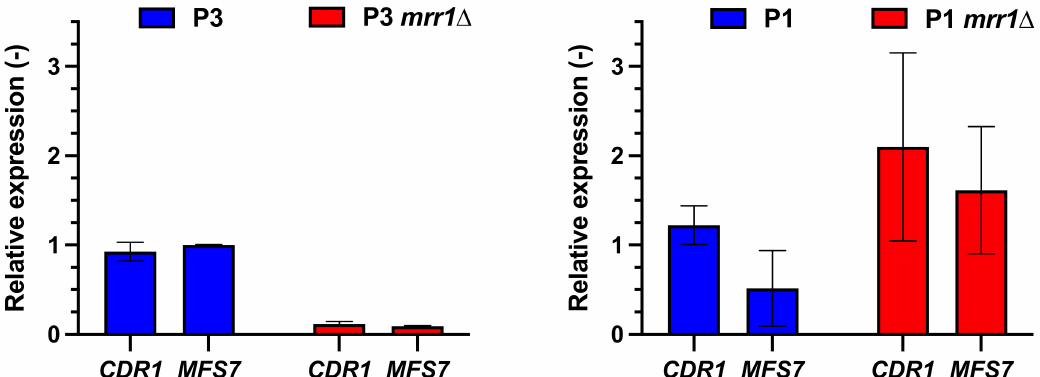
Figure 2. CDR1 and MSF7 are regulated by MRR1 in isolate P3. qPCRs were performed as described in Material and Methods. Expression fold-changes were reported to the parent isolates P1 and P3, respectively. The P3 isolate contains the MRR1 GOF mutation V668G, while P1 contains a wild type MRR1